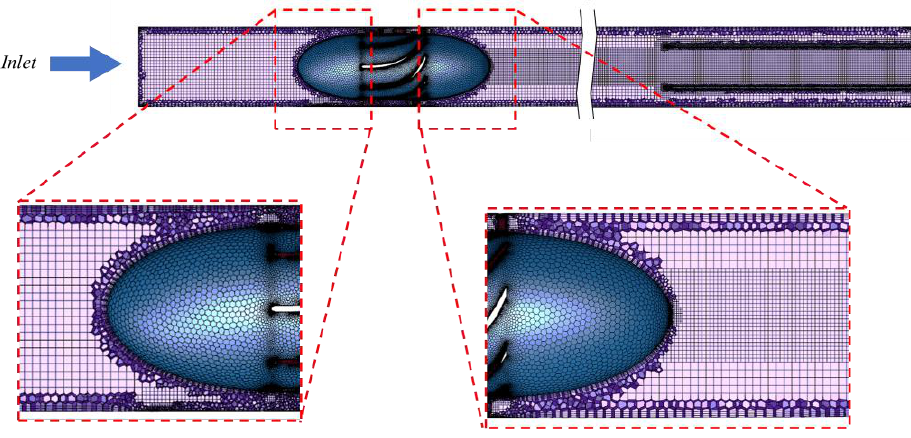
Figure 3. Grid systems. Figure 3. Grid